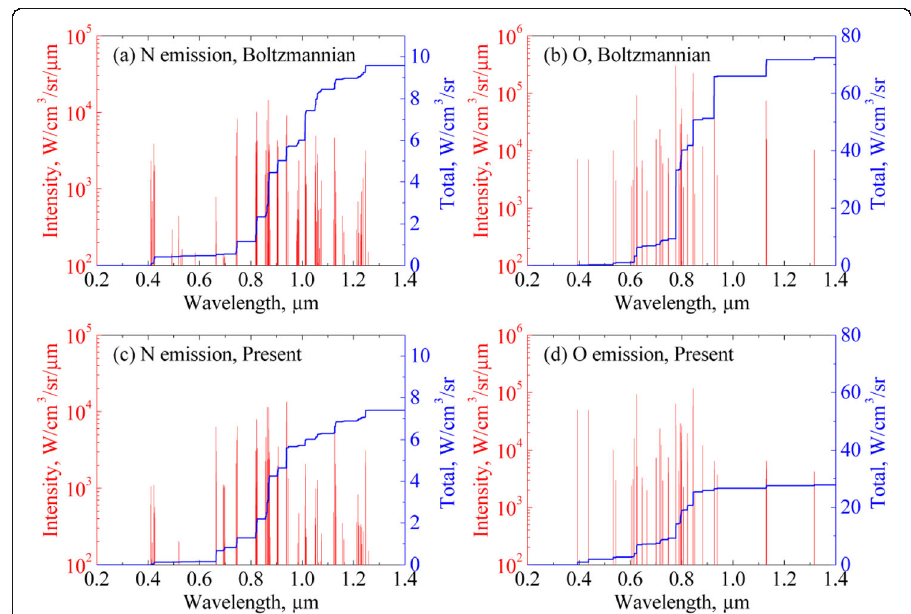
Fig. 1 Spectral emission of N ( a ) and O ( b ) assuming a Boltzmannian distribution with T e . Nonequilibrium emission of N ( c ) and O ( d ) using the present method